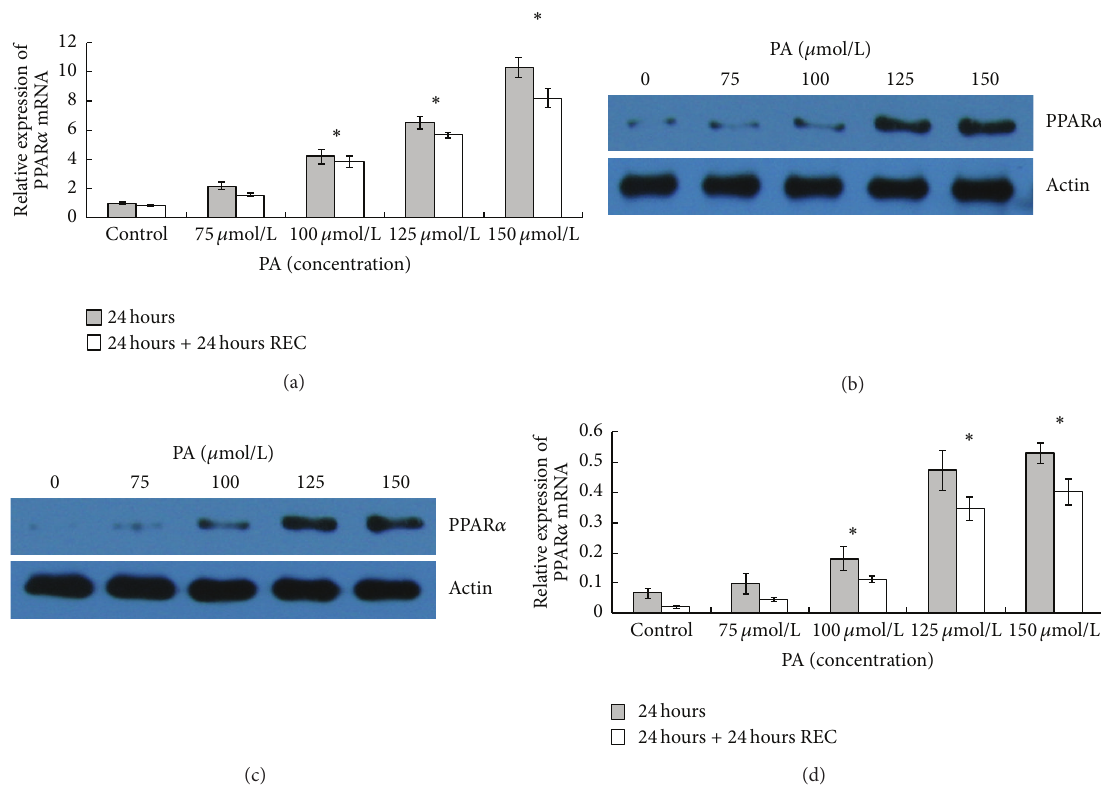
Figure 5: PA induces an upregulation of PPAR 𝛼 mRNA and protein levels in HaCaT keratinocytes. HaCaT keratinocytes were untreated or treated with PA (75, 100, 125, and 150 𝜇 mol/L) for 24 hours in serum-free conditions, and collected immediately and 24 hours after PA depletion. (a) PPAR- 𝛼 mRNA levels were determined by real-time RT-PCR. The values shown represent mean ± SD of three experiments. Expression of PPAR 𝛼 after treated or untreated with PA immediately (b) and 24 hours (c) were detected by western blotting. The band intensities were evaluated by densitometric analysis (d). The values shown represent the mean ± SD of three experiments. Asterisks ( ∗ ) indicate significant differences of 𝑃 < 0.05 , respectively, between the PA-treated groups and nontreated